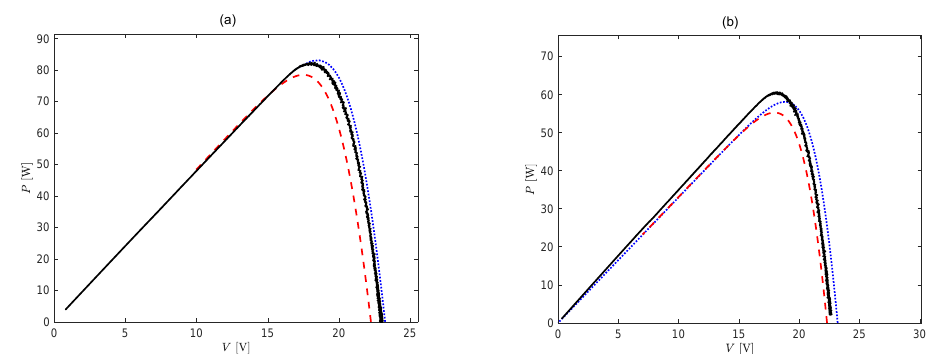
Figure 9. Electrical power of a PV module obtained experimentally (black lines) in Turin (Northern Italy) and by solving the one- (dashed red lines) and the three-dimensional (dotted blue lines) models when the cooling is active (in ( a ) Flow rate of 30 L/h, G = 1023 W m − 2 , T a = 287.45 K; in ( b ) Flow rate of 52 L/h, G = 700 W m − 2 , T a = 288.15 K). In both conditions, the measured water temperature T in = 294.45 K.